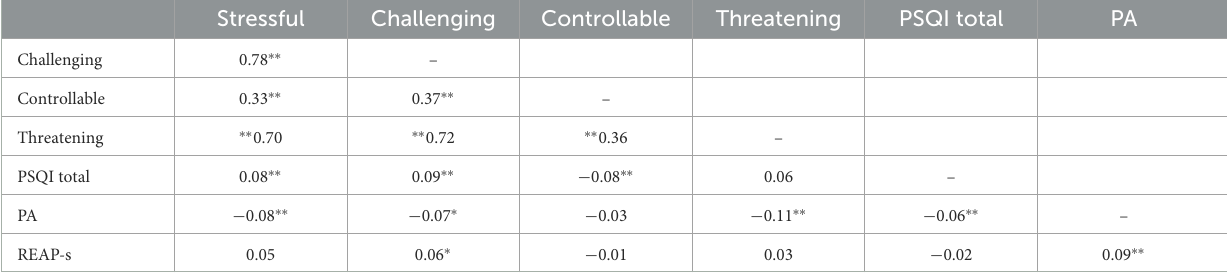
TABLE 3 Correlations between the personal COVID-19 experience, PSQI, physical activity, and REAP-S in athletes. Stressful Challenging Controllable Threatening PSQI total PA